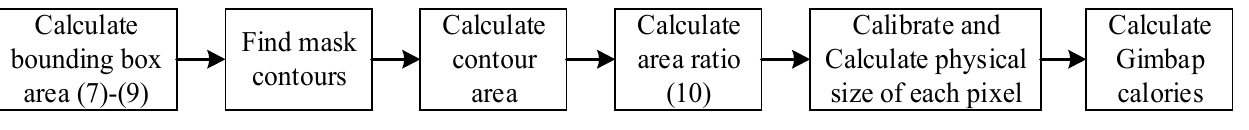
Figure 6. Gimbap calorie estimation diagram.